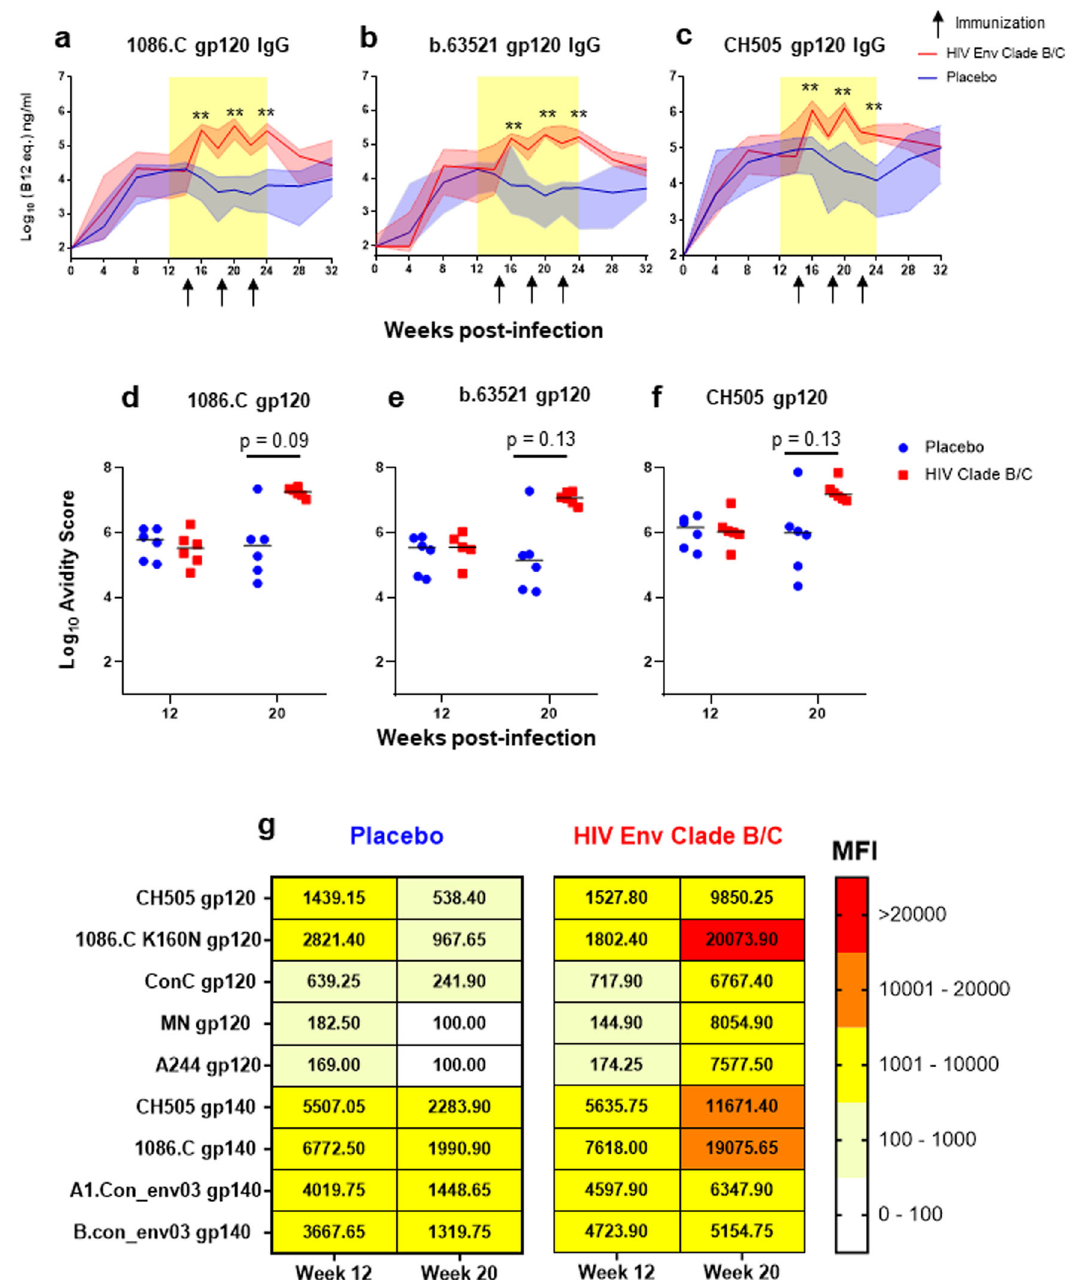
Fig. 2 Plasma gp120-specifc IgG antibody binding kinetics, avidity, and breadth. Plasma gp120 IgG binding responses to vaccine antigens 1086.C ( a ) and b.63521 ( b ), and challenge virus antigen, CH505 ( c ) in placebo (blue) and Env vaccinated (red) macaques. Bold lines represent the median, and the range is depicted by the shaded area; black arrows indicate time points at which immunizations were administered (14, 18, and 22 wpi). Antibody avidity was assessed against vaccine and challenge antigens at week 12, pre-ART/immunization, and at week 20 when IgG gp120 binding peaked in the Env vaccinated group ( d – f ). Dot plots represent avidity score, each dot represents one animal, and medians are represented by horizontal lines ( d – f ). Statistical analysis was performed using Wilcoxon rank-sum tests with exact p -values to compare gp120-specifc IgG binding (Supplementary Table 3) and avidity (Supplementary Table 4) responses between vaccinated and placebo RMs, followed by FDR adjustments for multiple comparisons. **unadjusted p < 0.01. FDR adjusted p -values are reported in the dot plots. See Supplementary Table 3 and 4 for both unadjusted p and FDR_p for all comparisons. g Comparison of gp120 and gp140 IgG binding breadth at pre-ART/immunization, week 12, and at peak IgG binding post-immunization, week 20. Data shown are median MFI for each antigen for placebo (left panel) and HIV Env vaccinated (right panel) immunization time point, and at 20 wpi, the time point at which with decreased MTCT risk of HIV 20,21 . To determine the impact of gp120-speci fi c IgG binding responses were highest in the HIV Env vaccination on the breadth and epitope speci fi city of the vaccinated cohort. For both groups, anti-V3 and CH505 V1V2 plasma Env-speci fi c IgG responses, we assessed binding to various binding responses were dominant at week 12 (Fig. 3a). Yet, by HIV Env linear and conformational epitopes. Antibody epitope week 20 (2 weeks post- 2nd immunization), the HIV Env speci fi city in the two groups were measured at 12 wpi, a pre-ART/